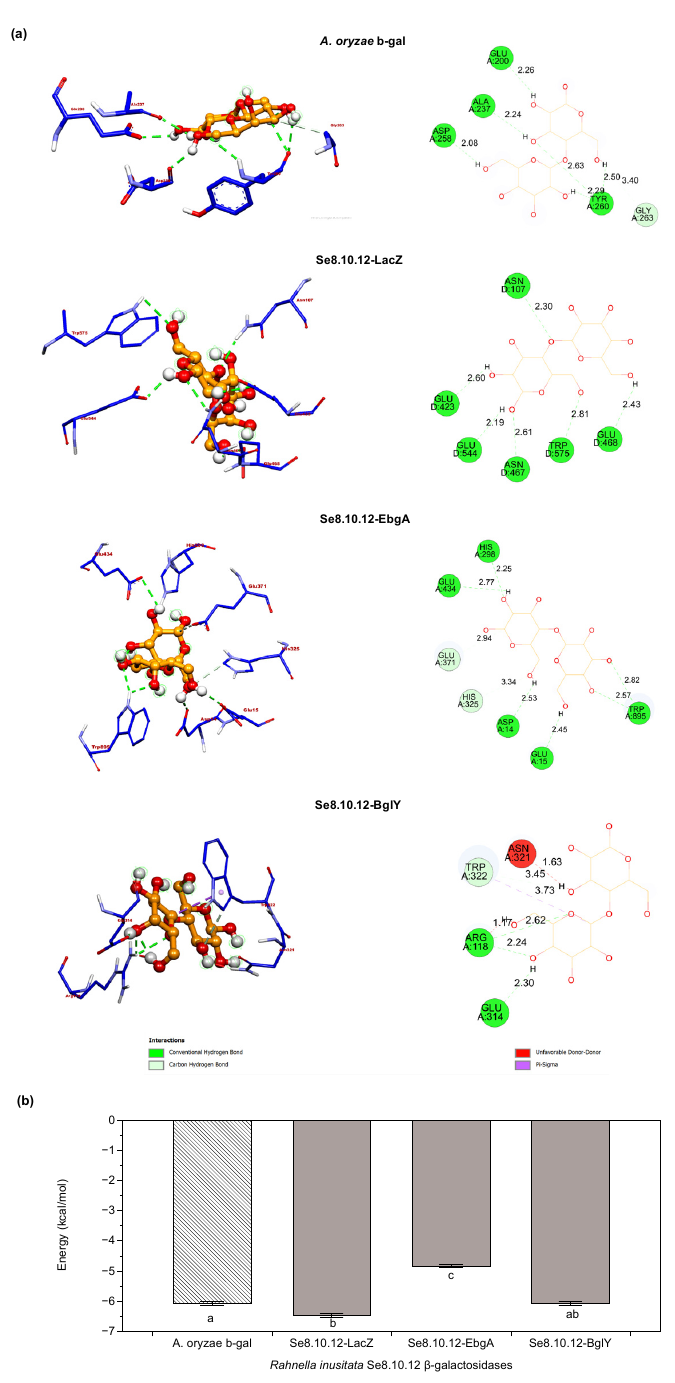
Figure 9. Molecular docking of the Rahnella inusitata Se8.10.12 β -galactosidases and its substrate lactose. ( a ) Molecular docking simulation of lactose binding to Aspergillus oryzae β -galactosidase (4IUG) and Rahnella inusitata Se8.10.12 β -galactosidases LacZ, EbgA, and BglY (homology modeling). Schematic representation showing enzyme/ligand interactions (left image) and two-dimensional (2D) ligand-protein interaction diagram (right). The hydrogen bonds are represented dotted green lines (Å). ( b ) Docking scores (AutoDock Vina) for lactose against the selected β -galactosidases. Error bars denote SE of mean; n = 5. Different letters represent statistically significant differences between models (Kruskal–Wallis test; p < 0.05).